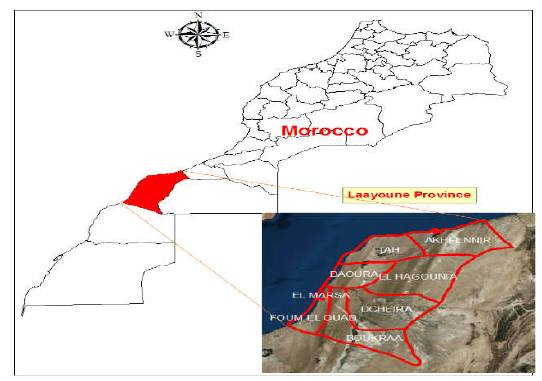
Figure 1. Location of the study ar